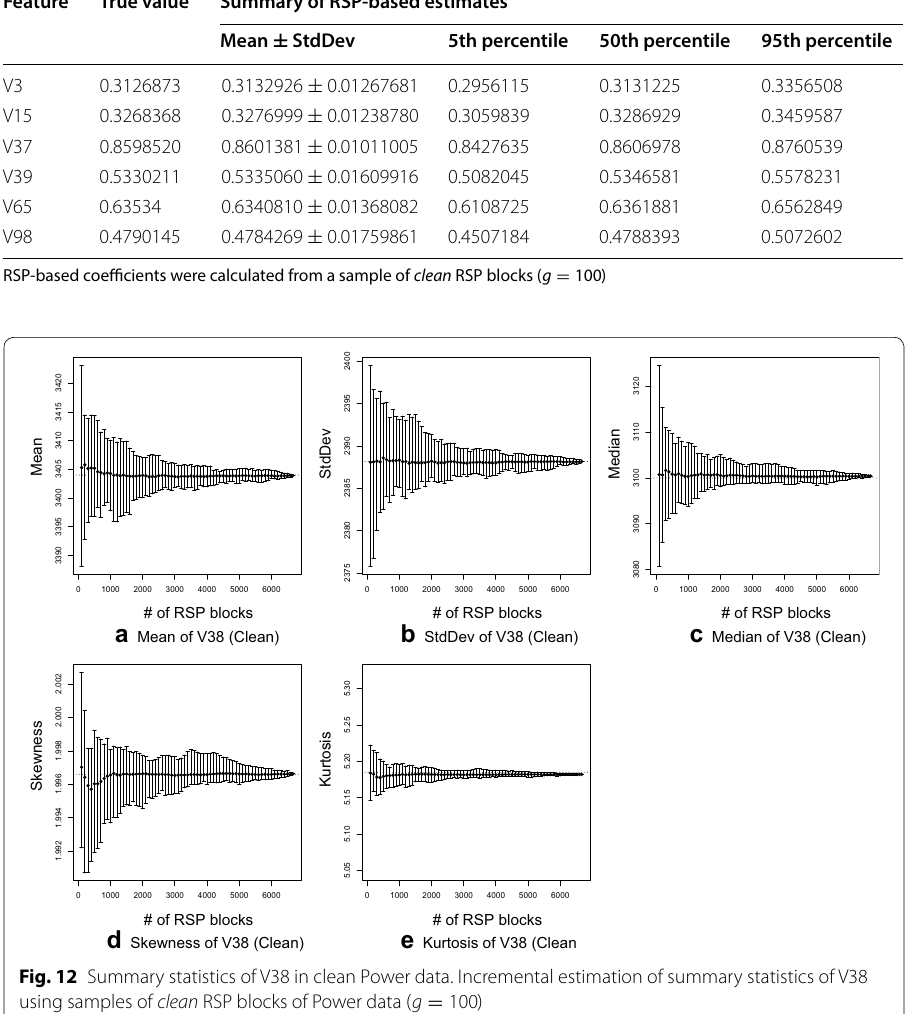
Table 9 Correlation between V38 and 6 other features in clean Power data